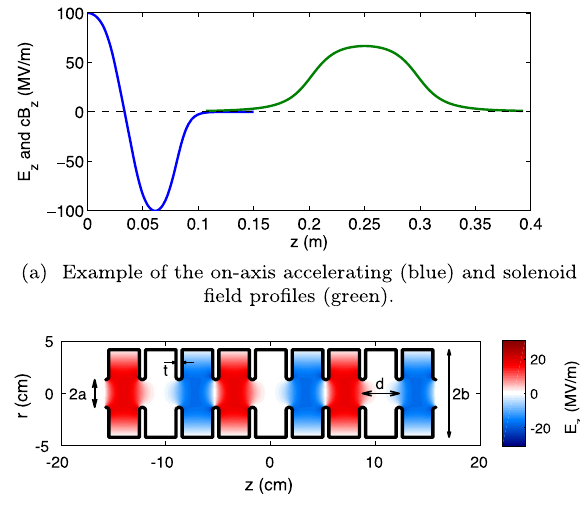
FIG. 1. Field description for the 1.6-cell gun and solenoid (a), as well as the buncher (b).